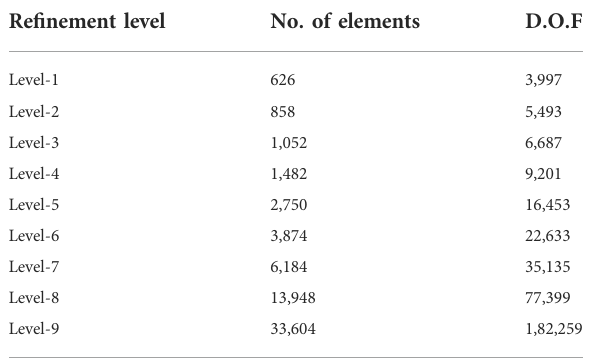
TABLE 1 Mesh statistics against different re fi nement levels.